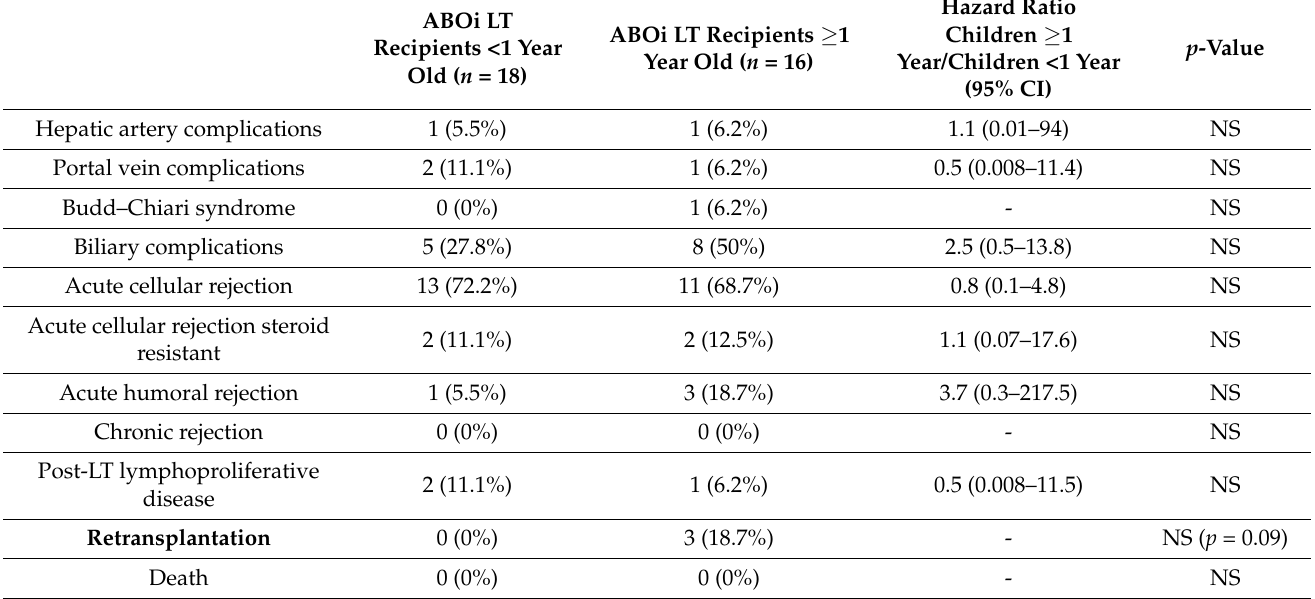
Table 3. Post-transplant complications according to recipient age (<1 year versus ≥ 1 year) among 34 ABO-incompatible liver transplantations performed at the Cliniques Universitaires St Luc (Brussels, Belgium) between February 2005 and April